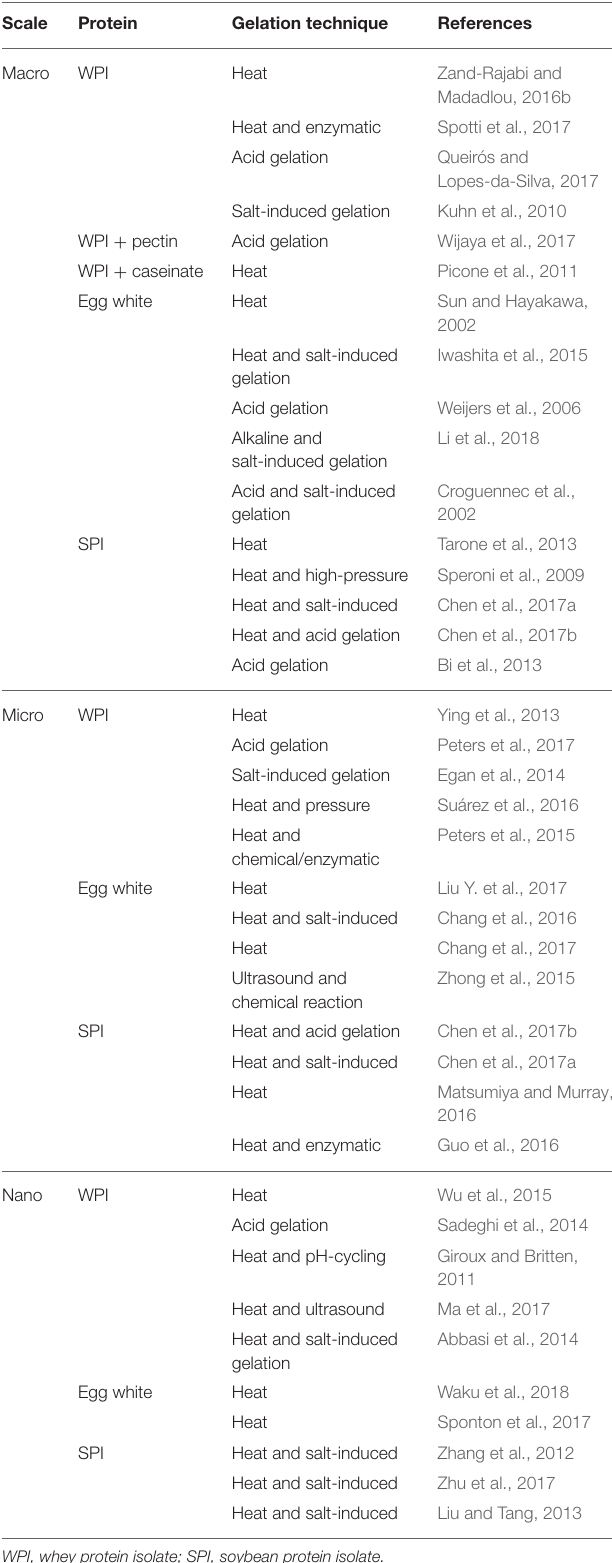
TABLE 1 | Examples of protein-based structures at different sizes using different gelation approaches.